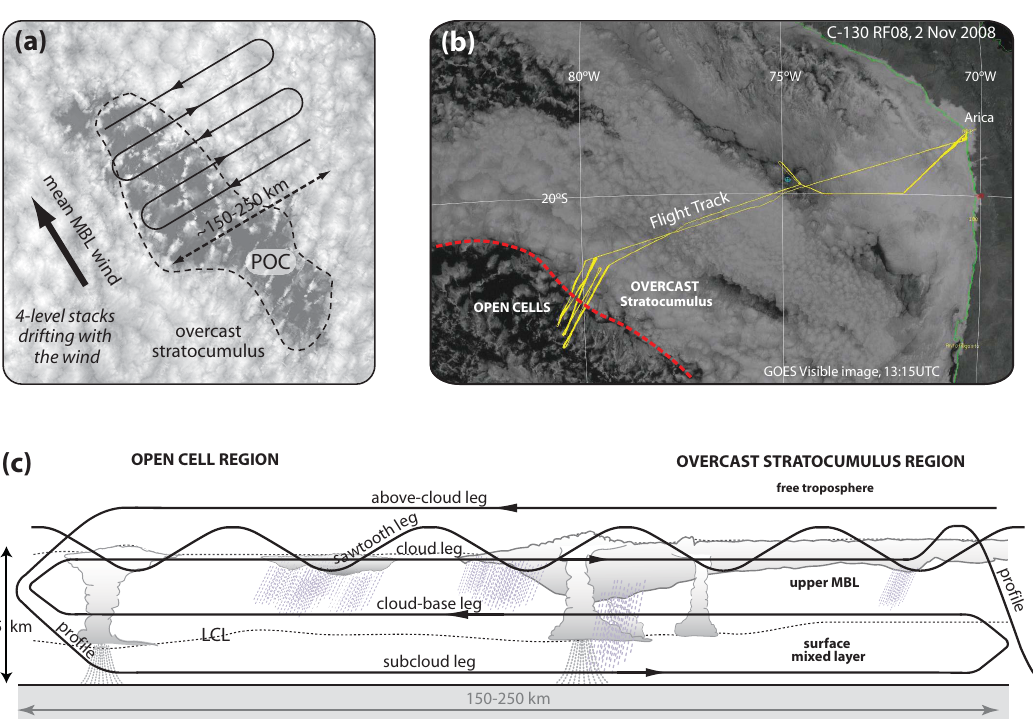
Fig. 7. POC-Drift mission flight plan. (a) schematic of plan view; (b) example POC-Drift misson flight track from C-130 Research Flight RF08 on 2 Nov 2008; (c) schematic cross section of boundary between open and closed cell regions showing sampling using long straight and level runs 150–250km in length, profiles, and sawtooth sampling through the upper part of the MBL and lower troposphere. Due to its reduced range the BAe-146 sampled a subset of the C-130 flight plan when sampling